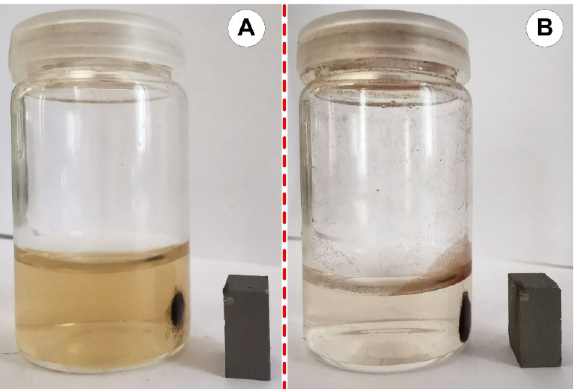
Figure 10. PEG- coated IONPs separation in the presence of the magnetic field. ( A ) cubic IONPs, ( B ) spherical IONPs. ( B ) spherical